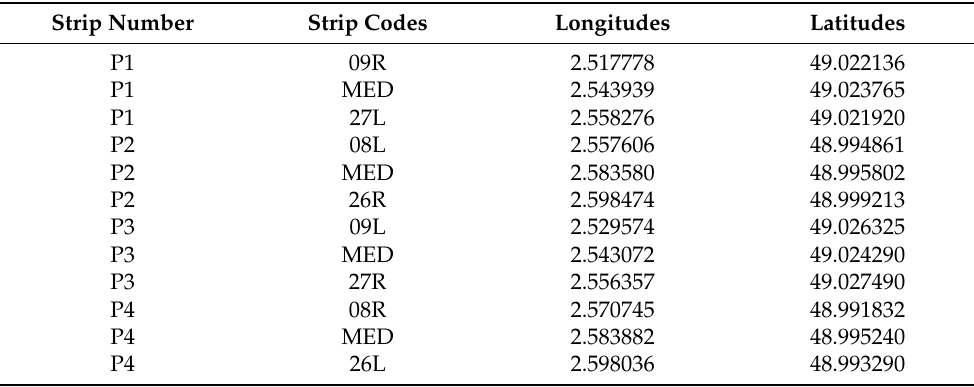
Figure 1. ( A ) Localisation of Paris-CdG airport: urban areas are gray, the forest area is in dark green and rural lands are in color (this figure was made from the French geographical portal (accessed date 20 October 2021)—www.geoportail.gouv.fr). ( B ) Zoom on the Paris-CdG airport: the circles indicate the visibility sensors at their GPS positions with their names. Table 1. Strips codes and GPS coordinates of visibility